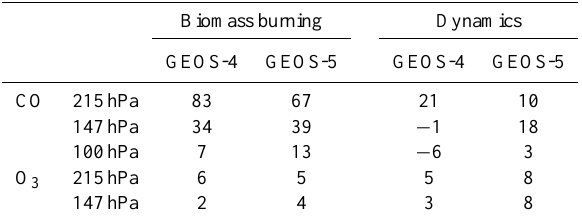
Table 2. Contributions to tropical upper tropospheric CO and O 3 concentrations over western and central Indonesia from biomass burning and dynamics. Values are averages for October and Novem- ber 2006. Unit: